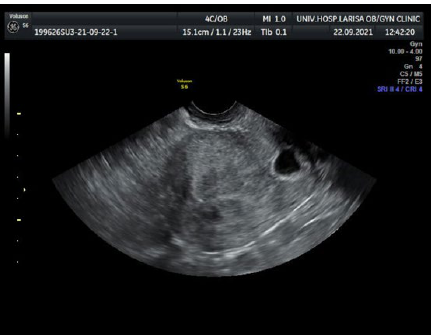
Figure 2. Transvaginal ultrasound 7 days after methotrexate administration.